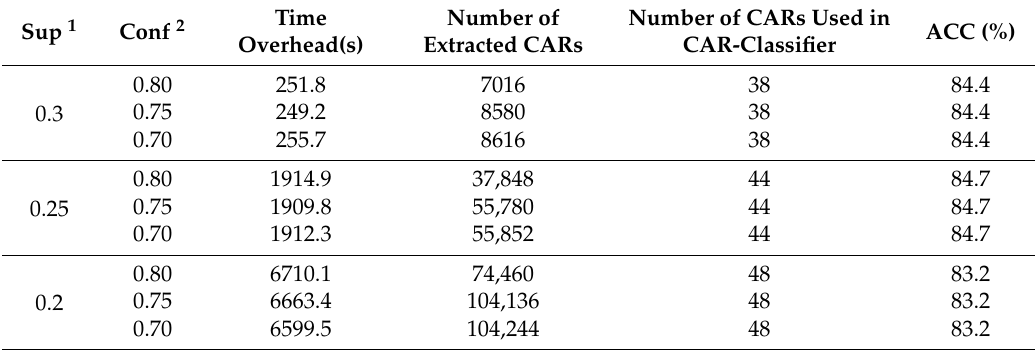
Table 5. The construction of the CAR-Classifier using different support and confidence.